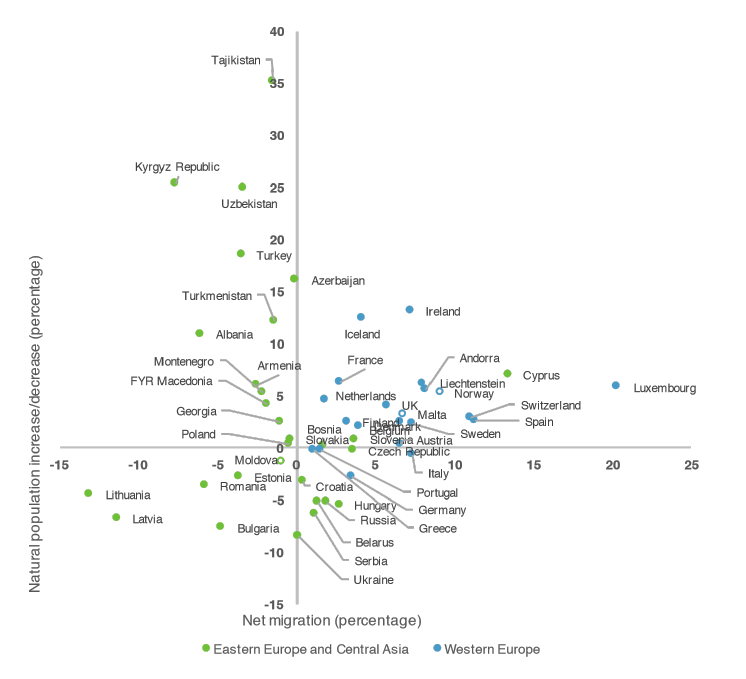
Figure 2: Net migration and natural and total population growth, ECA (green) countries versus